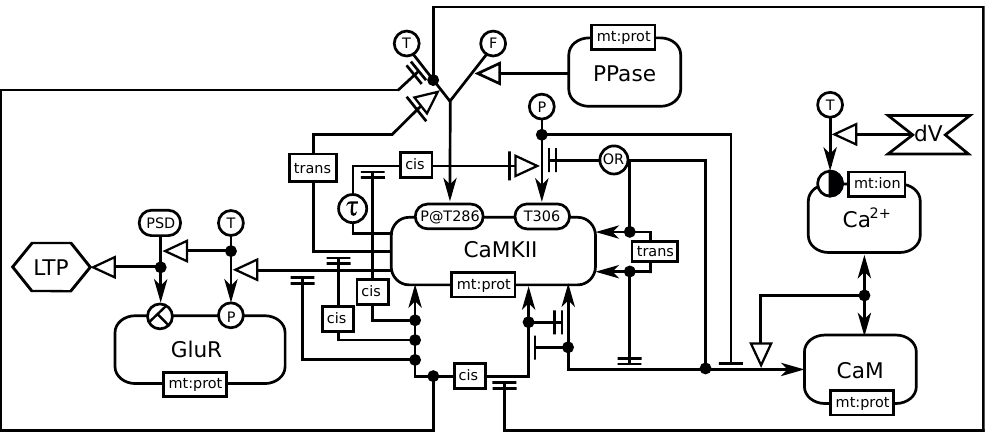
Figure A.10: Regulation of calcium/calmoduline kinase II effect on synaptic